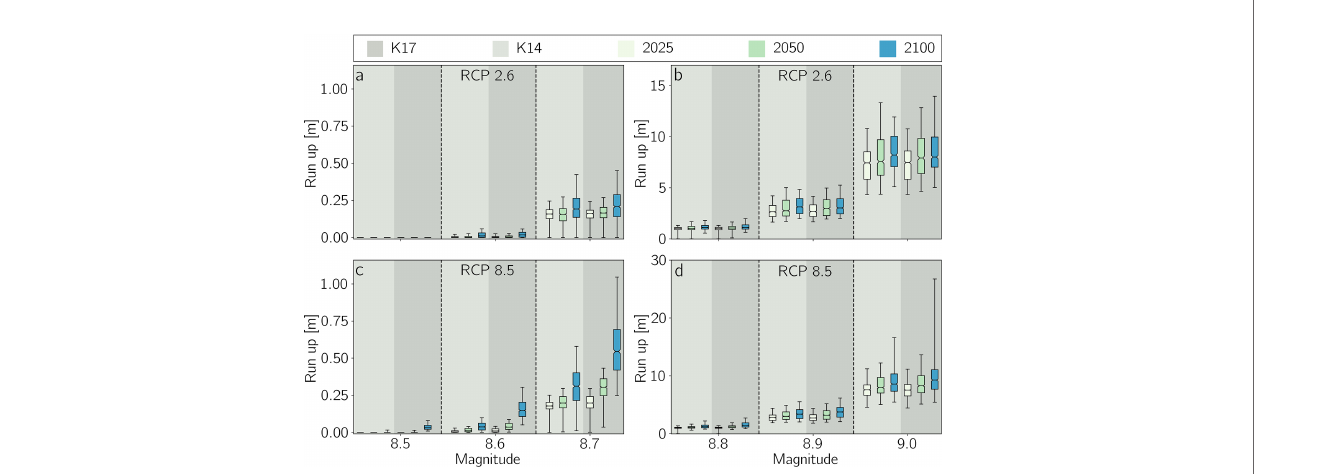
FIGURE 7 | Comparison between run-up as a function of tsunami-genic earthquake magnitude and between RCP 2.6 for both K14 (A) and KP 16 (B) and the RCP 8.5, likewise for K14 (C) and K17 (D) . The green-blue colors represent the years 2025, 2050, and 2100, while light and gray backgrounds respectively represent K14 and K17. The colored boxes represent the 17-83 percentile range, while the line within the box denotes the medians. The lower and upper whiskers mark the 5 - 95 percentile